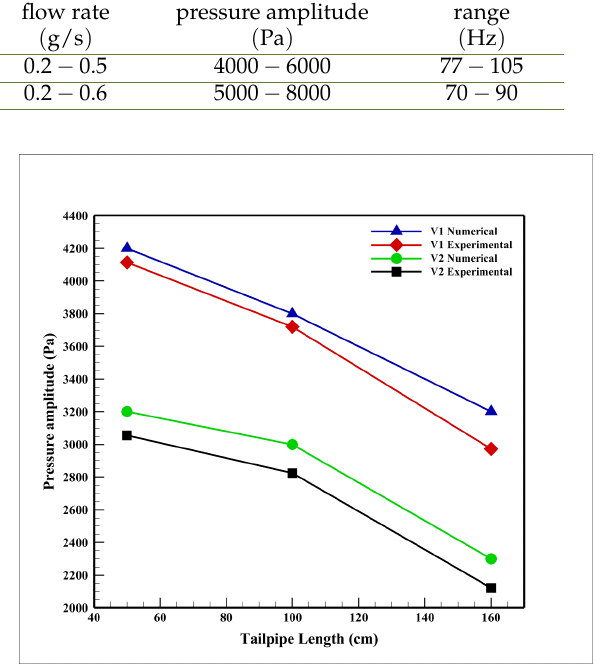
Fig. 6. The variation of pressure amplitude with the tailpipe length for V1 and V2 the experimental